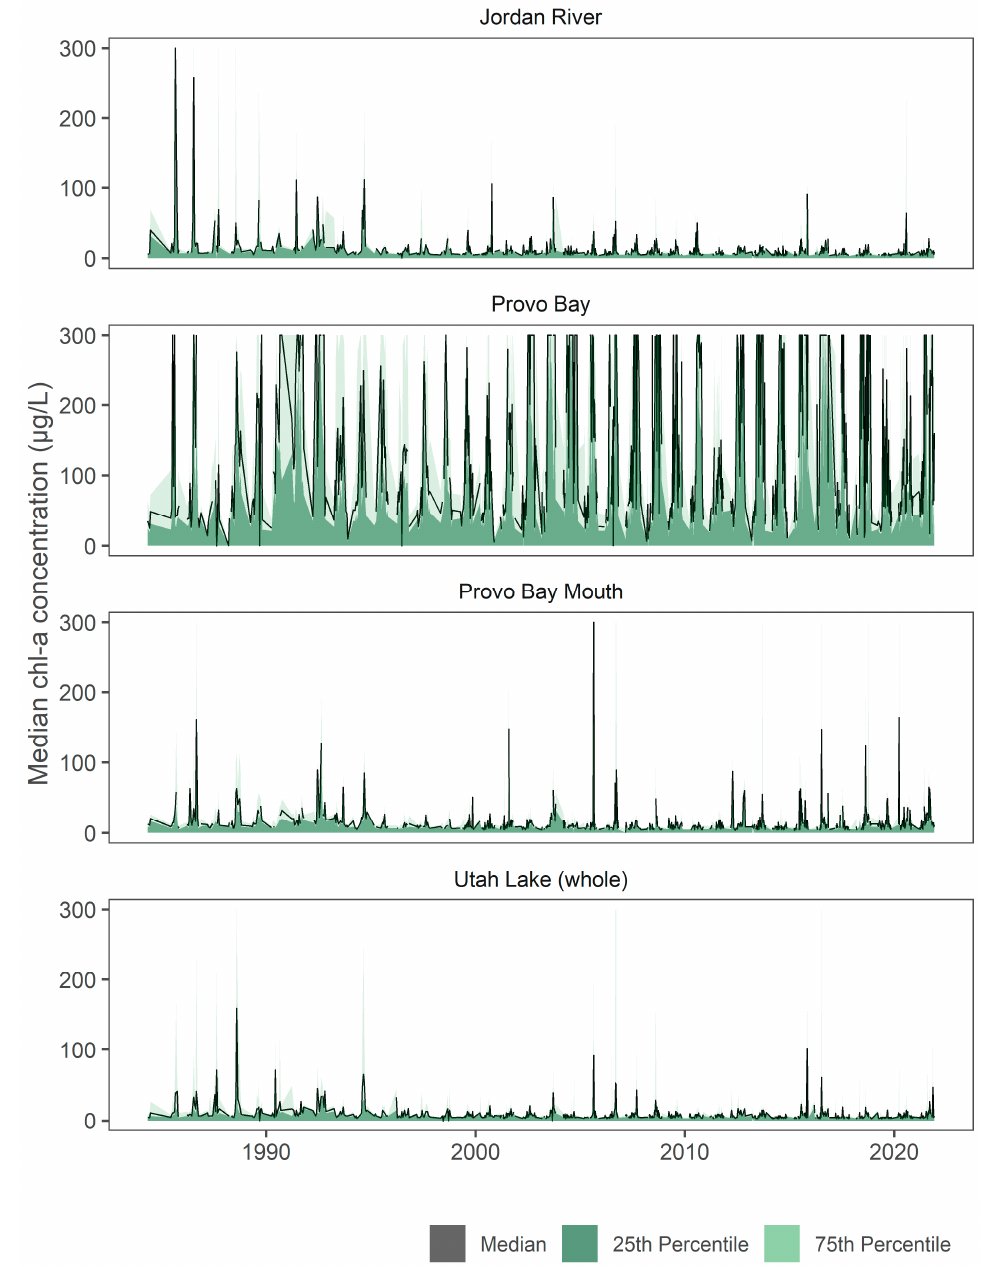
Figure 12. Median chl-a values from March through November for selected analysis regions. These plots show the large variability of the data, the difference among regions, sea- sonal patterns, and differences between wet and dry periods which cause lake levels to fluctuate. The electronic supplement contains plots for the other analysis regions. Figure 12 shows that in the late 1980 ′ s there were large spikes in algal concentrations. These spikes correspond to the large algal bloom shown in Figure 1 and the top panels in Figure 8.